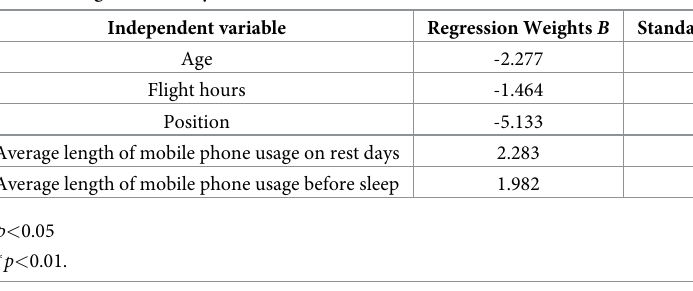
Table 11. Regression analysis